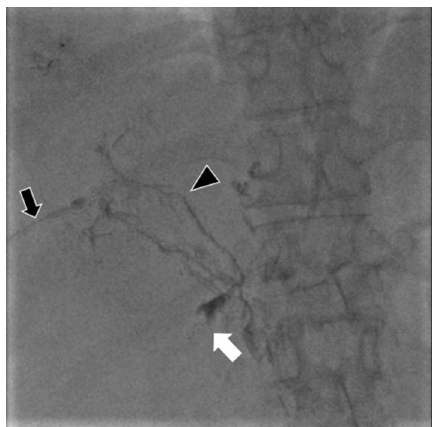
Fig. 2 Findings of percutaneous transhepatic lymphangiography (PTL). PTL image showing lymph vessel (black arrowhead) and point of leakage (white arrow) identified by contrast medium injected using a 22G Chiba needle (black arrow)